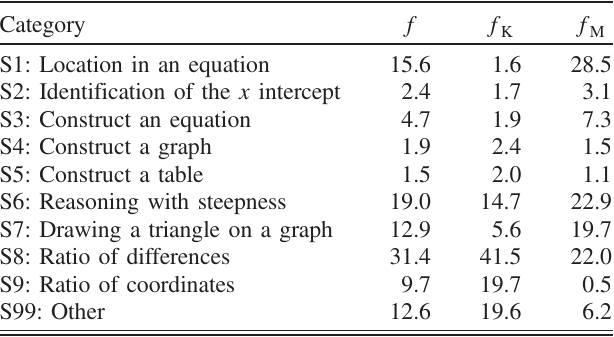
TABLE V. Frequencies (in %) for the slope questions. f is across both contexts, f is in the kinematics context and f K the mathematics context. The percentages are relative to 2501, 1202, and 1299,